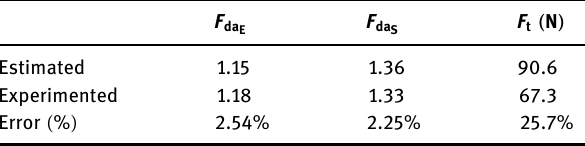
Table 6: Estimated and experimented response variables